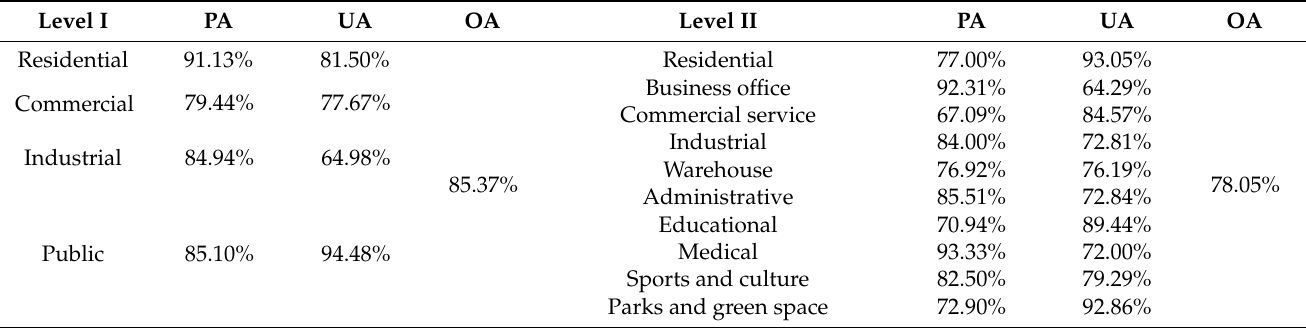
Table 8. Classification accuracy of Level I and Level II land-use features.